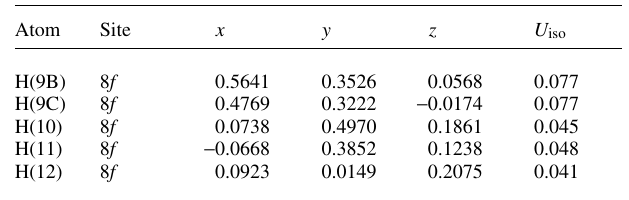
Table 2. Atomic coordinates and displacement parameters (in Å 2 )